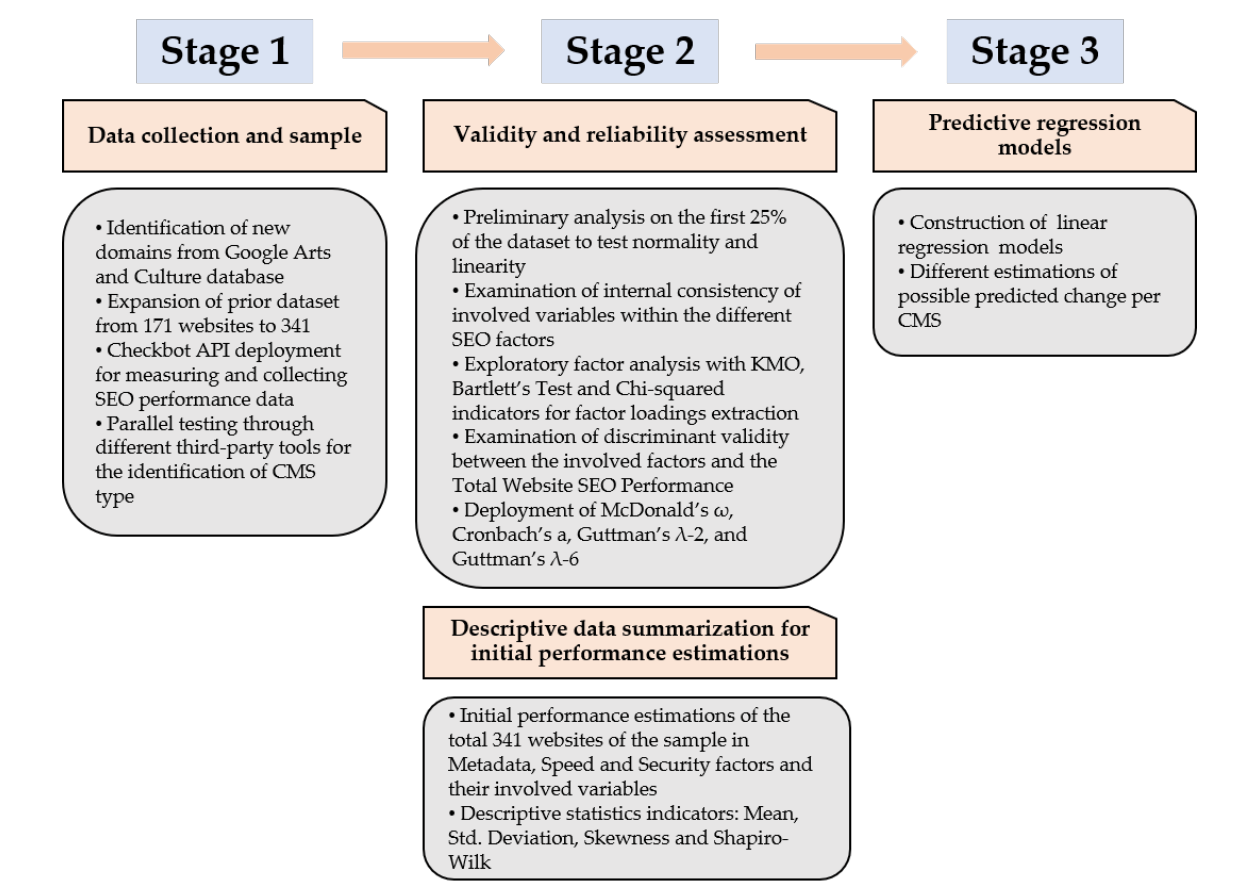
Figure 1. Proposed methodology schema to overcome the identified research barriers in expanding visibility and discover- ability of LAMs